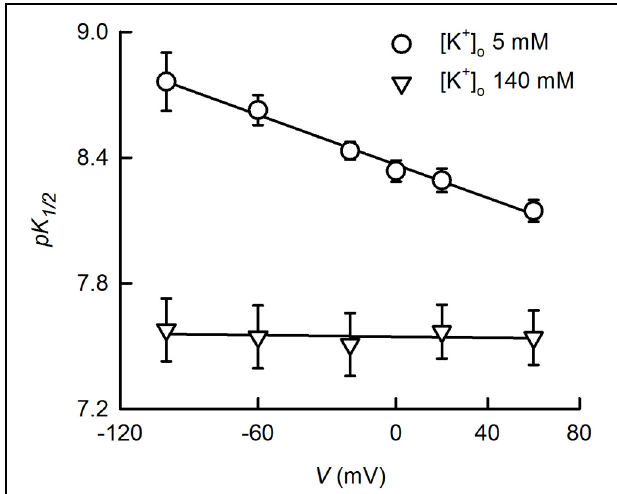
FIGURE 2 | K + - and voltage-dependence of TASK-gating by pH o . The dependence of K + currents upon extracellular pH was studied on HEK-293 cells previously transfected with TASK-2 cDNA. Measurements were done in the whole-cell recording mode of the patch-clamp technique as previously described (Niemeyer et al., 2007). The intracellular solution contained 140mM K + whilst extracellular K + was either 5 or 140mM. K + 5mM bath solution contained 135mM sodium gluconate, 1mM potassium gluconate, 4mM KCl, 2mM CaCl 2 , 1mM MgCl 2 , 105mM sucrose, 10mM HEPES/Tris, pH 7.5. Intracellular, pipette solution contained 8mM KCl, 132mM potassium gluconate, 1mM MgCl 2 , 10mM EGTA, 1mM Na 3 ATP, 0.1mM GTP, 10mM HEPES/Tris, pH7.4. Extracellular pH-dependence curves were generated at various voltages and fits of the Hill equation yielded the p K 1 / 2 values reported which are averages of fitted parameters of the individual experiments. Some of the experiments for the data presented here have been published before (Niemeyer et al., 2010). Use of the Woodhull (1973) model [p K 1 / 2 (V) = p K 1 / 2 (0mV)-z δ FV/2.303RT, where p K 1 / 2 (V) and K 1 / 2 (0mV) are the − log of the inhibitory dissociation constants at a given voltage V and at 0mV; δ is the fractional distance across the electric field crossed by H + ; and z, R, T, and F have the conventional meaning], on the data at 5mM K + , resulted in a δ -value of 0.22 and p K 1 / 2 (0mV) of